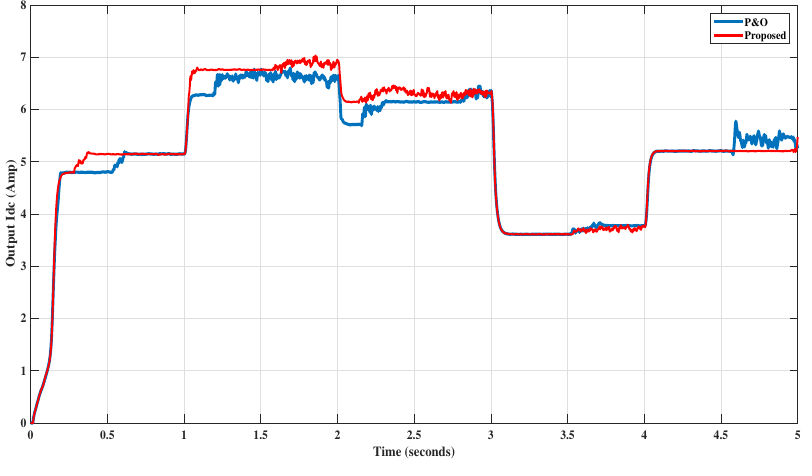
Figure 20. Time and DC